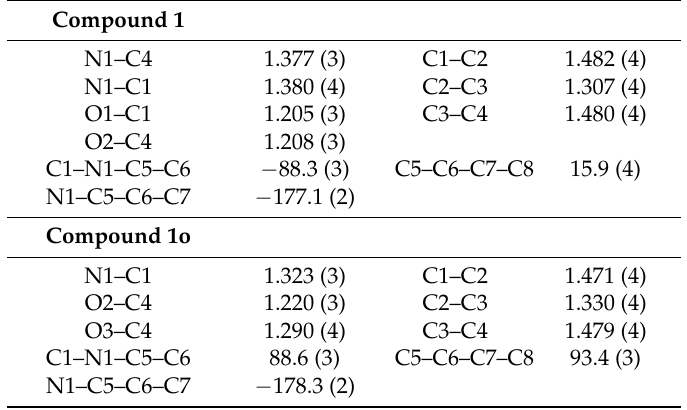
Table 2. Selected geometric features. Bond lengths (Å), valence angles ( ◦ ), and torsion angles ( ◦ ).